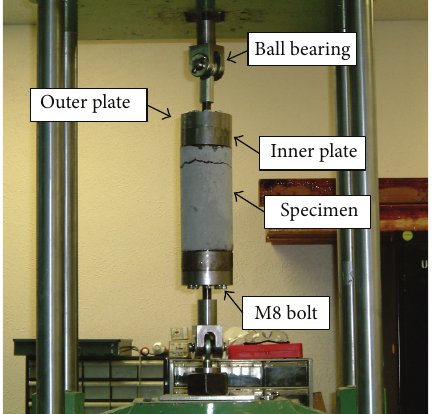
Figure 2: Direct tension test conducted by the proposed test